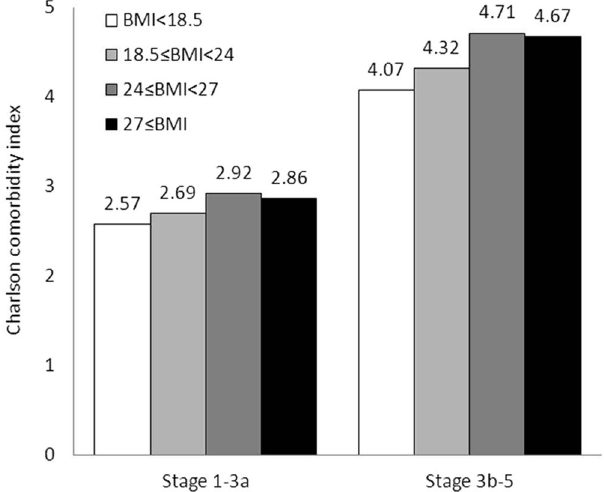
Figure 5. Charlson comorbidity score according to body mass index in patients with chronic kidney disease stages